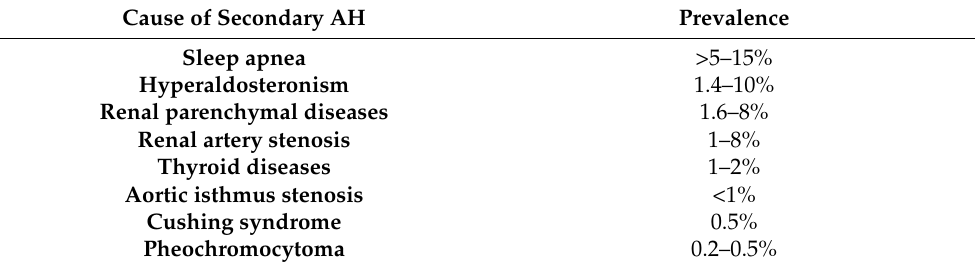
Table 2. The causes and prevalence of secondary hypertension